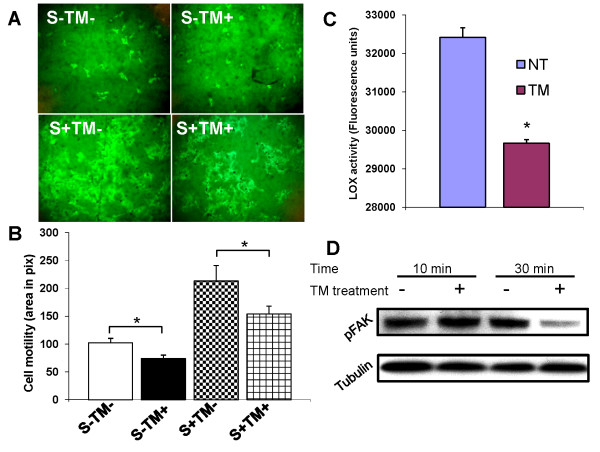
TM treatment significantly inhibits oral squamous cell motility. A-B; OSCC-3 cells were cultured on top of a field of microscopic fluorescent beads in the following culture conditions: in the absence of serum and TM (S-TM-); in the presence of serum but no TM (S+TM-); in the absence of serum but presence of TM (S-TM+) or in the presence of serum and TM (S+TM+). After a 16-hours incubation period, cells were fixed and areas of clearing in the fluorescent bead field corresponding to phagokinetic cell tracks were quantified using NIH ScionImager. C; LOX catalytic activity was measured in whole-cell lysates of untreated (NT) or TM treated OSCC-3 cells (30 minutes). *, represents a significant difference (p < 0.05) as compared to the control group. D; Whole cell lysates of untreated or TM treated OSCC-3 cells were separated using 4-12% NuPAGE Bis-Tris gels and probed with anti-phospho-FAK antibody. Equal sample loading was verified by stripping the blots and re-probing with anti-tubulin antibody.